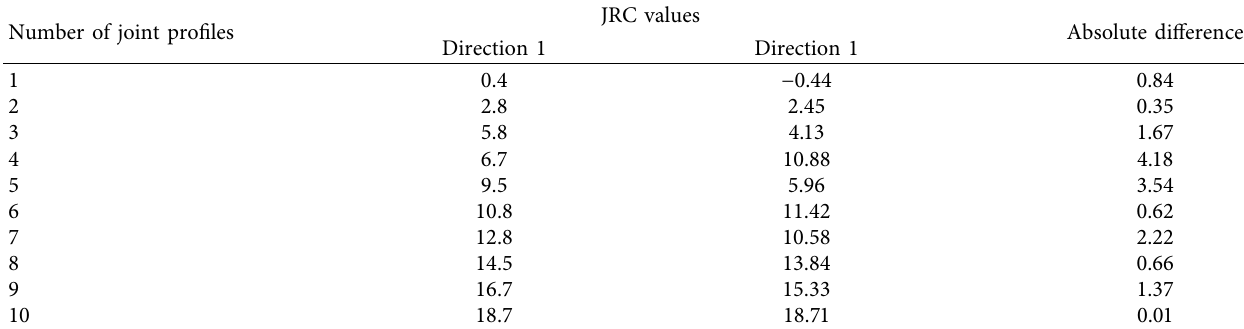
Table 3: Comparison of JRC values in different directions for 10 standard roughness joint profiles.